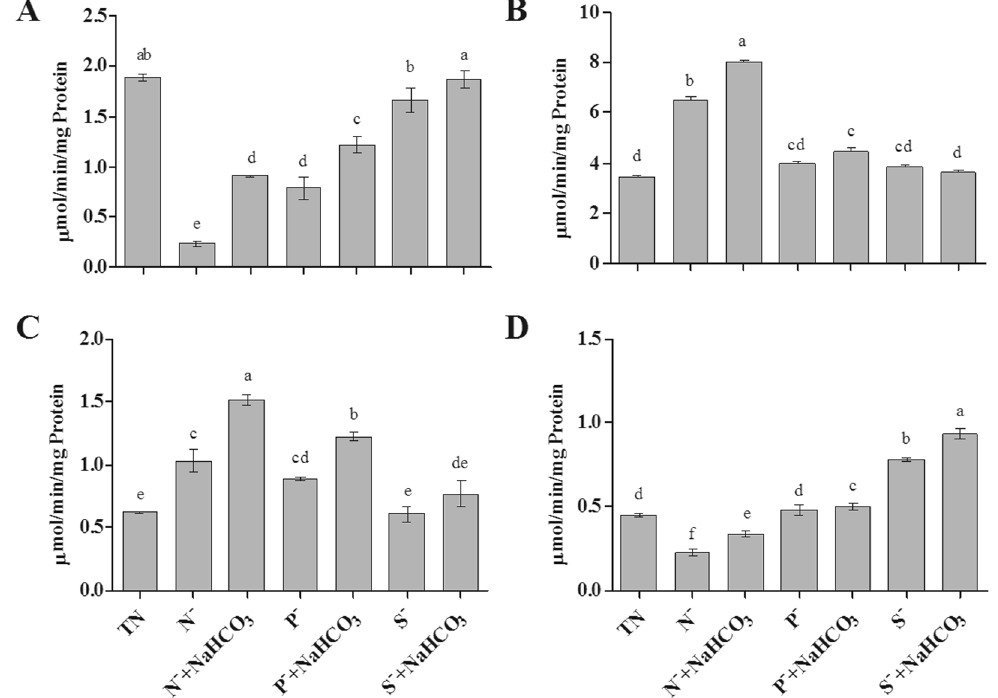
Figure 5. Changes in nutrient assimilatory enzymes nitrate reducatse ( A ), acid phosphatase ( B ), alkaline phosphatase ( C ) and ATP-sulfurylase ( D ) activity of D. salina with bicarbonate under nutrient deficit conditions. All values are expressed as Mean ± SD (n = 3). Values with different letters represent significantly differ at p < 0.05 between the groups. Total Nutrient (TN); Nitrate deficit (N − ); Nitrate deficit with bicarbonate (N − + NaHCO 3 ); Phosphate deficit (P − ); Phosphate deficit with bicarbonate (P − + NaHCO 3 ); Sulphate deficit (S − ); Sulphate deficit with bicarbonate (S − + NaHCO 3